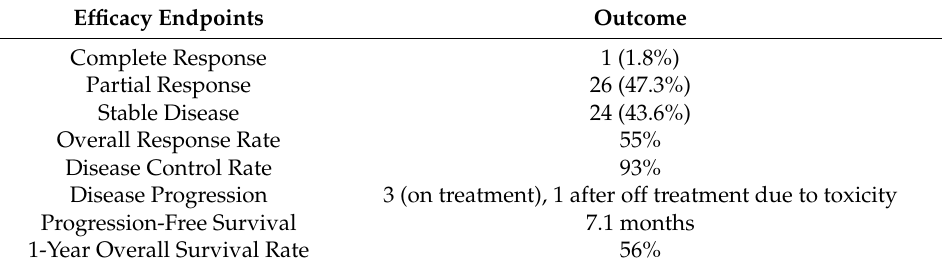
Table 2. Results of a phase I/II clinical study to investigate napabucasin in combination